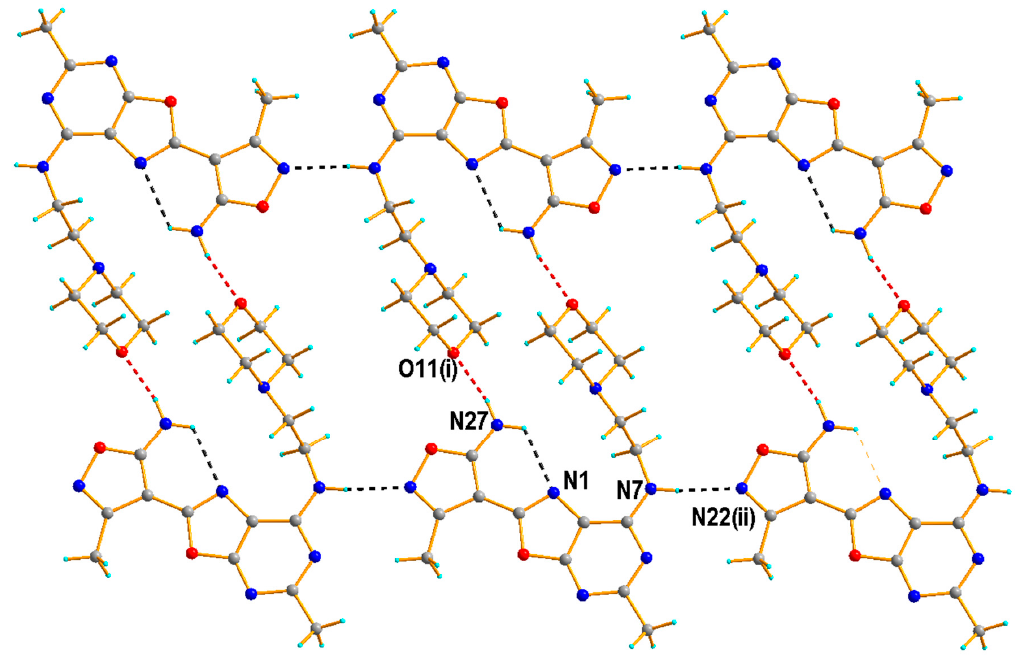
Figure 3. Crystal packing diagram of 5h , showing dominating N—H ··· N and N—H ··· O hydrogen bond interactions, viewed along the a axis. (The dashed lines indicates N—H ··· N (black) and N—H ··· O (red) hydrogen bonds. Symmetry codes: (i) − x, − y + 1, − z; (ii) x + 1, y − 1, z.).